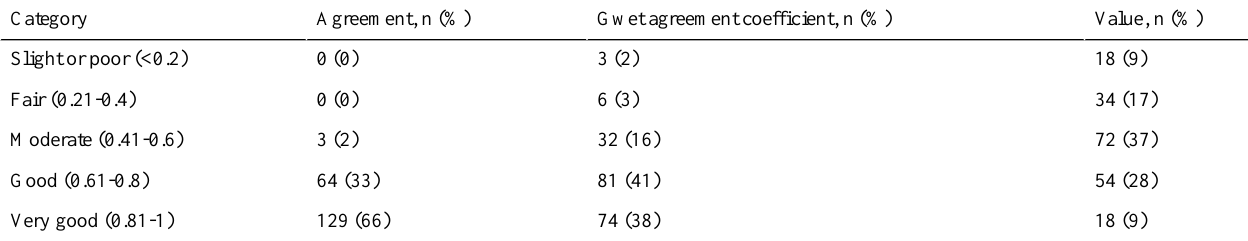
Table 2. Store Scout measurement items by interrater reliability category (N=196).